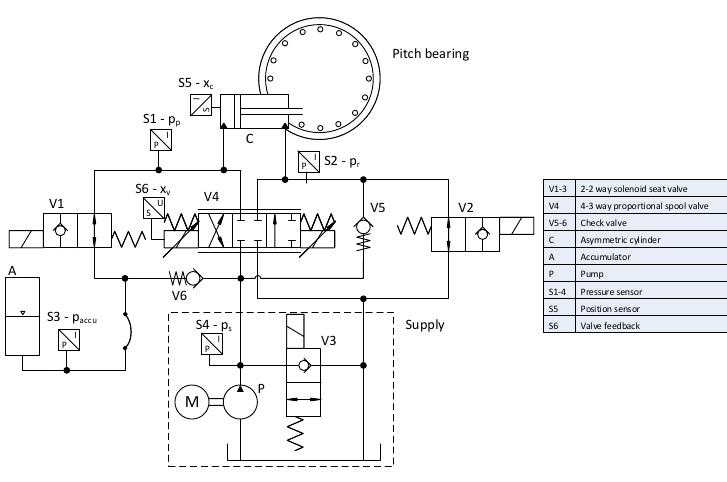
Figure 1. Simplified example of fluid power pitch